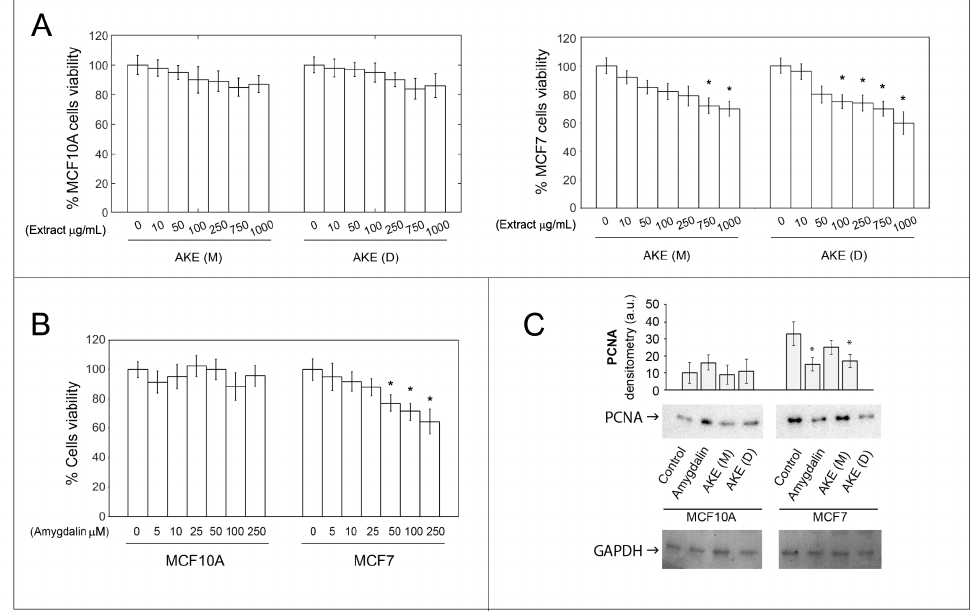
Figure 2. Effect of amygdalin and apricot kernel extracts on cell viability and PCNA levels. The MTT assay was carried out to measure cell viability in MCF10A and MCF7 cells. Cells were treated with increasing concentrations of maceration extract and decoction extract (Panel ( A )) and amygdalin (Panel ( B )) for 24 h. Results are expressed as percent toward untreated cells. Data points marked with an asterisk are statistically significant compared with the respective untreated control cells (* p < 0.05). ( C ) Representative Western blots for PCNA and relative densitometry is reported. GAPDH was used as control for equal protein loading. Data points marked with an asterisk are statistically significant compared with the respective untreated control cells (* p <